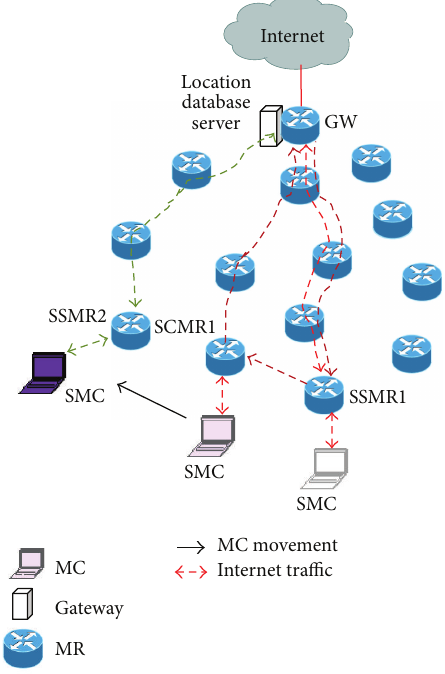
Figure 1: Routing of Internet